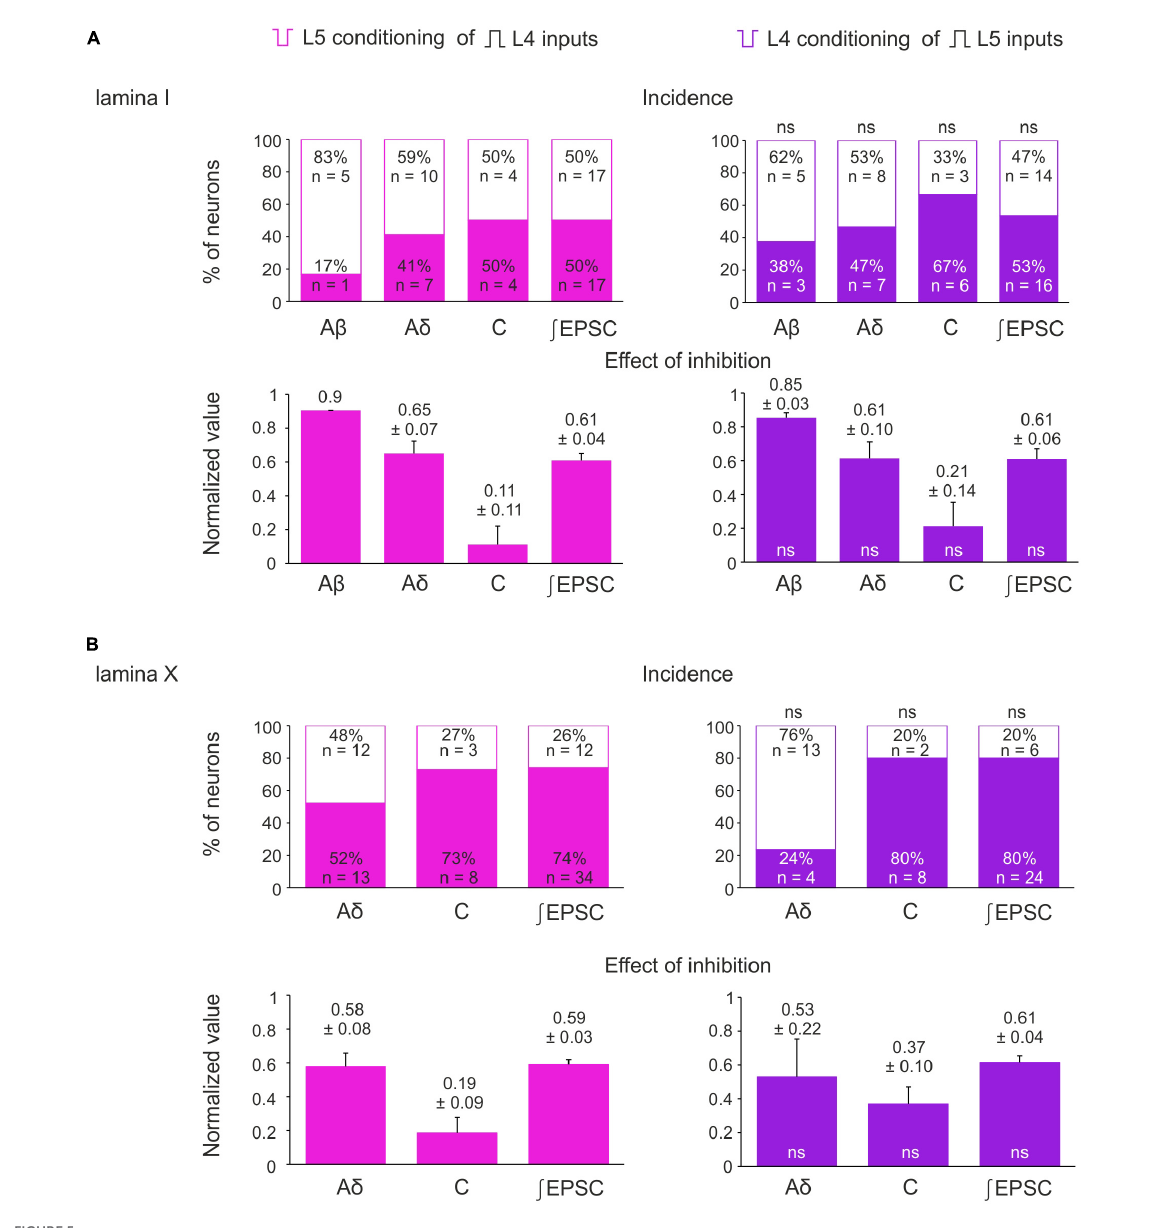
FIGURE5 Incidence and strength of the heterosegmental C-AD-PI in spinal laminae I and X. (A,B) Top rows: percentage of lamina I neurons (A) and lamina X neurons (B) showing significant changes in the amplitude of their monosynaptic input and the excitatory postsynaptic current (EPSC) area after heterosegmental C-fiber conditioning. Bottom rows: decrease in the monosynaptic input amplitude and the EPSC area caused by the heterosegmental C-fiber conditioning. Data are represented as mean ± standard error of the mean (SEM). ns, no significant difference when compared to respective parameter from the left column (Fisher’s exact test and Student’s t -test for the incidence and the effect of inhibition,